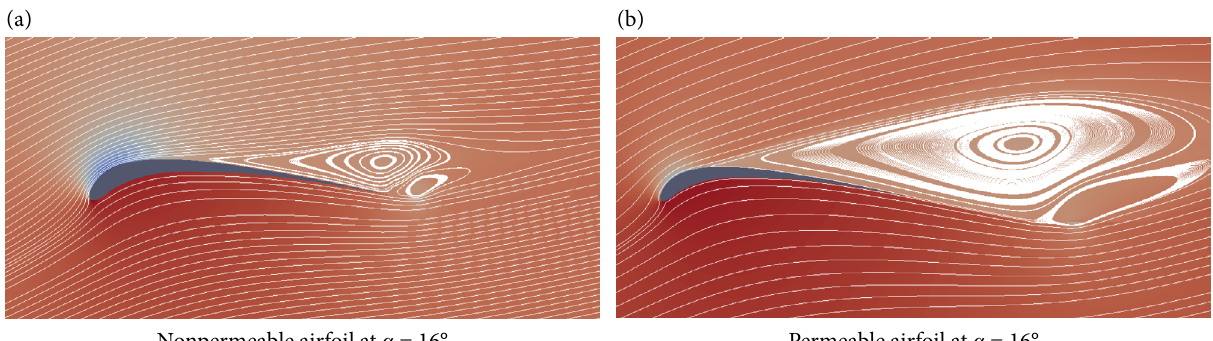
Figure 14. Exhibition of streamlines at high angle of attack for permeable and nonpermeable eagle’s